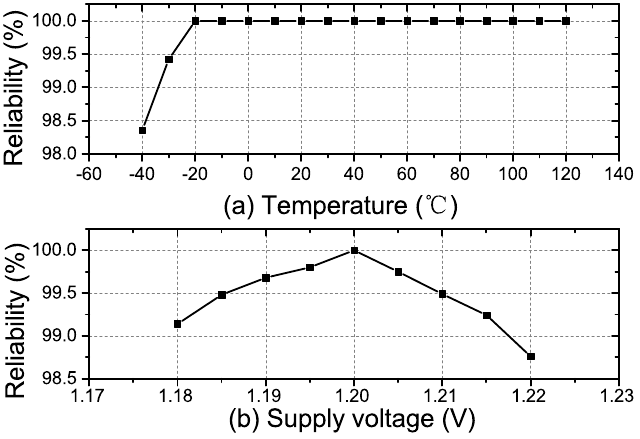
Figure 8. ( a ) The measured average reliability of the proposed RO PUF versus the temperature variations; ( b ) the measured average reliability of the proposed RO PUF versus the voltage variations.